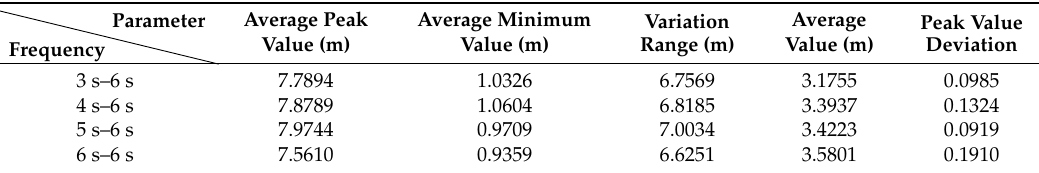
Table 11. Pressure values and statistical analysis after air inflow has been cut off for 6 s when the slot nozzle is set at the bottom of the pipe.